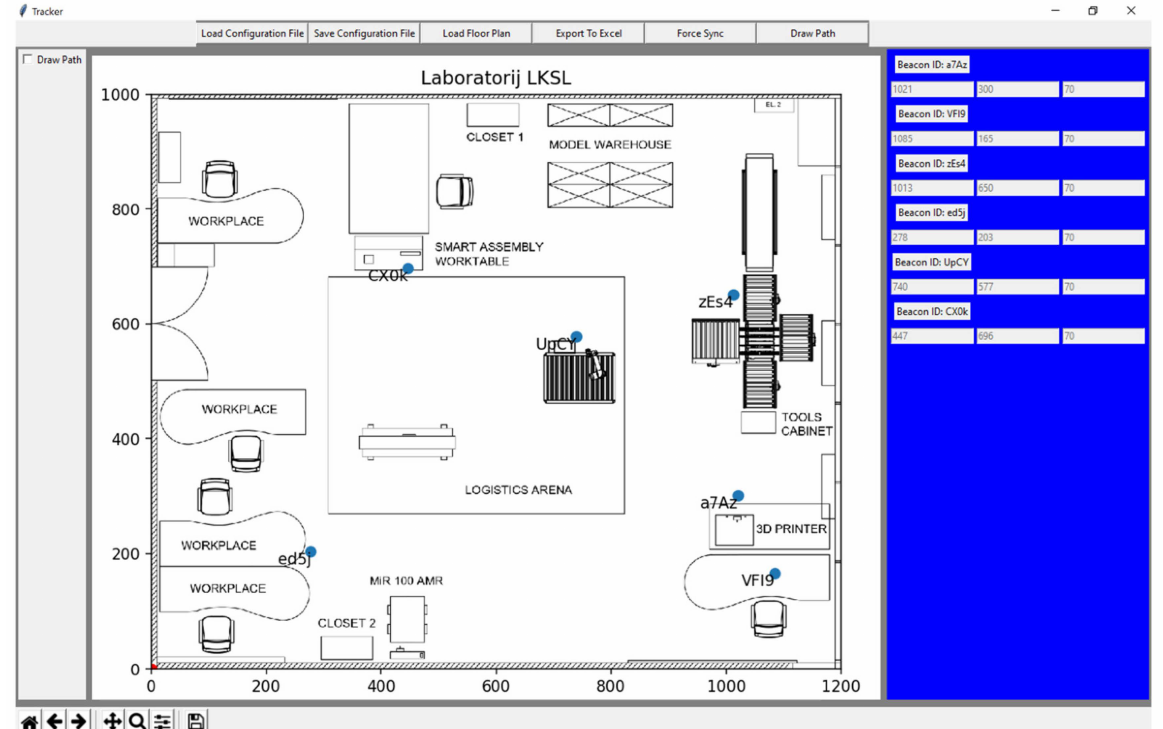
Figure 8. Tracker application main window.